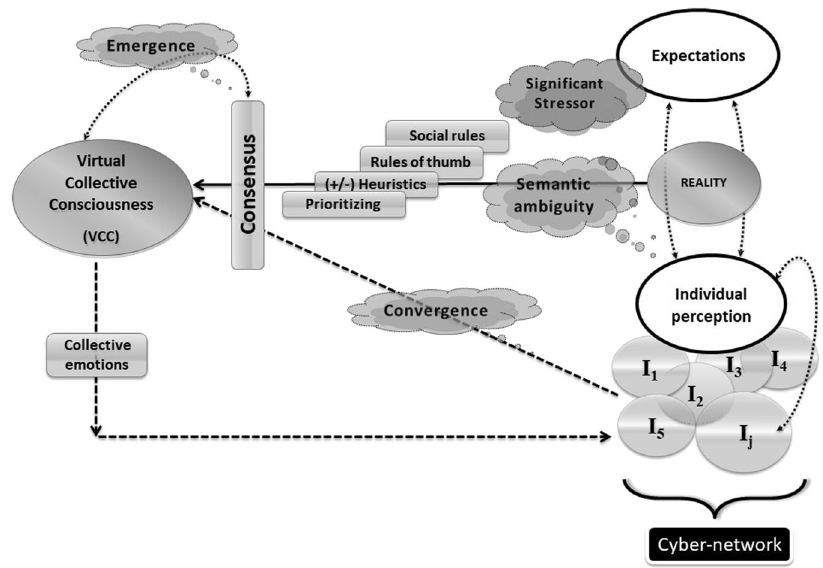
Fig. 7 The VCC dynamic model. A tentative model to account for the dynamics of users ’ knowledge via the interaction with the cybernetwork and the perceived virtual collective consciousness when facing a signi fi cant